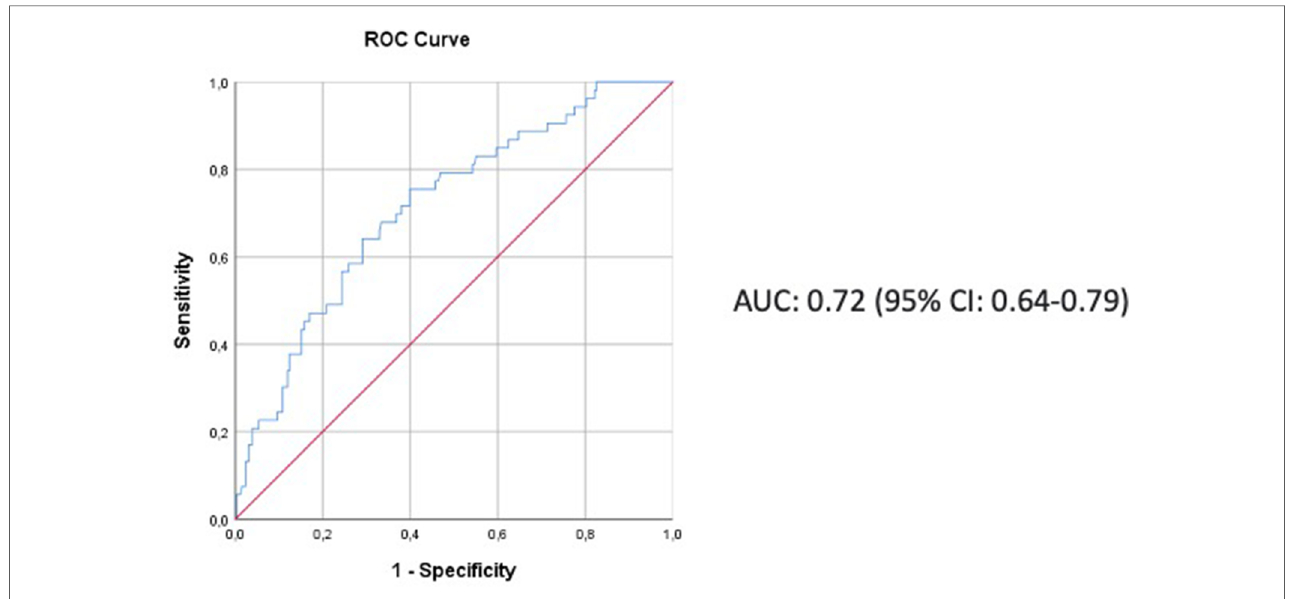
FIGURE 1 The ROC curve showing the discriminant power of the